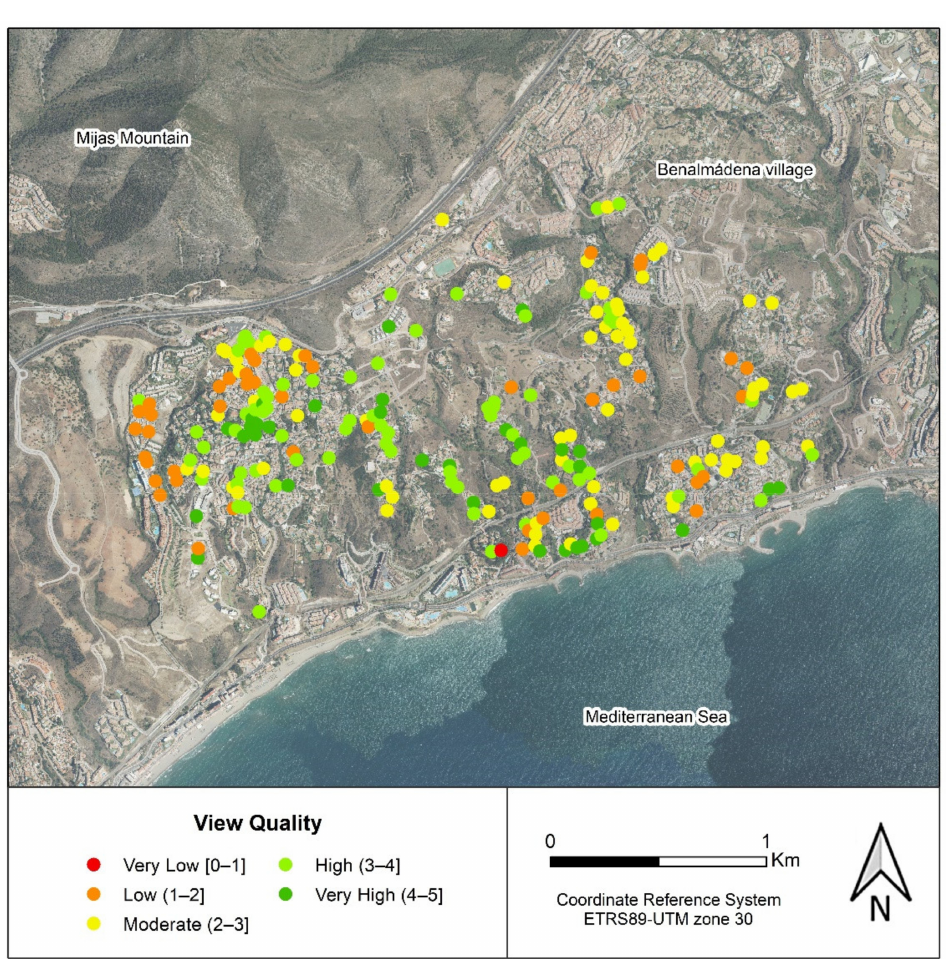
Figure 10. Buildings analyzed, according to the view quality index (own